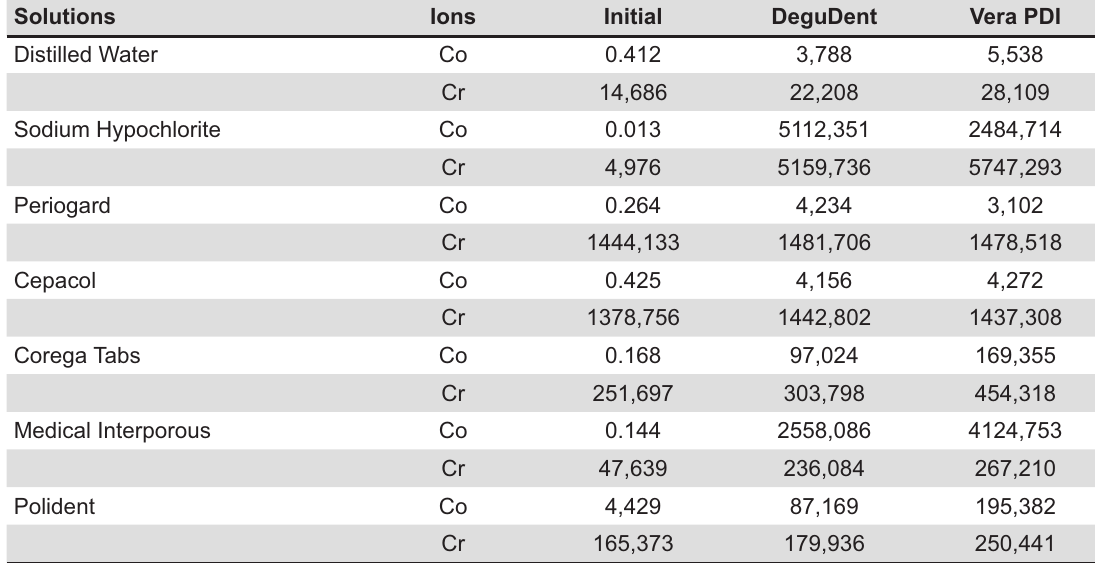
Table 3- Absolute values of ion release ( (cid:2)